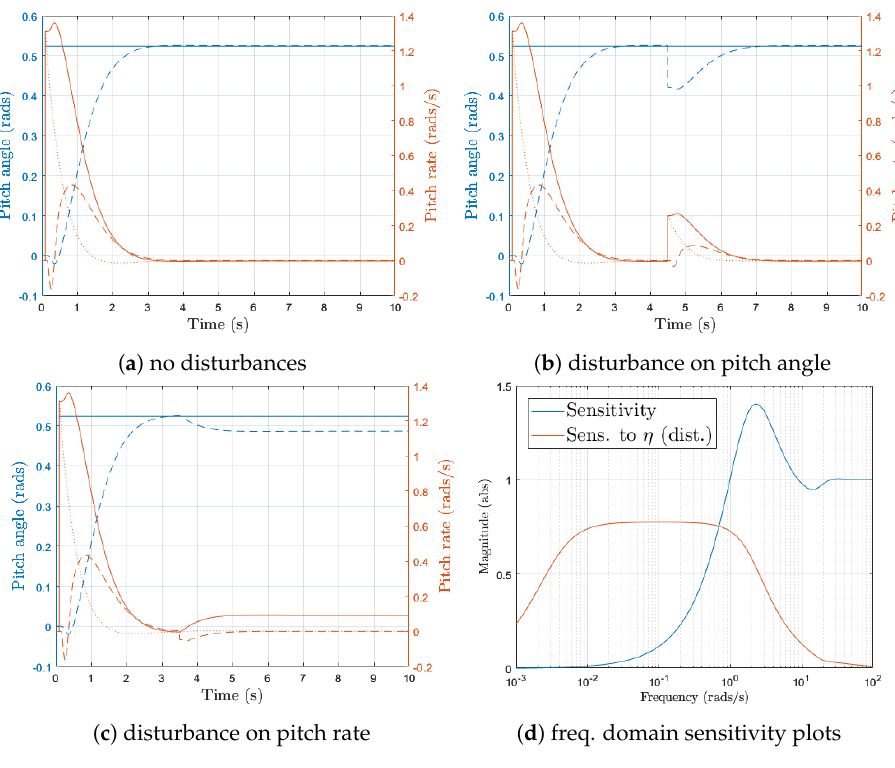
Figure 7. PFCD time domain response (disturbances applied independently).